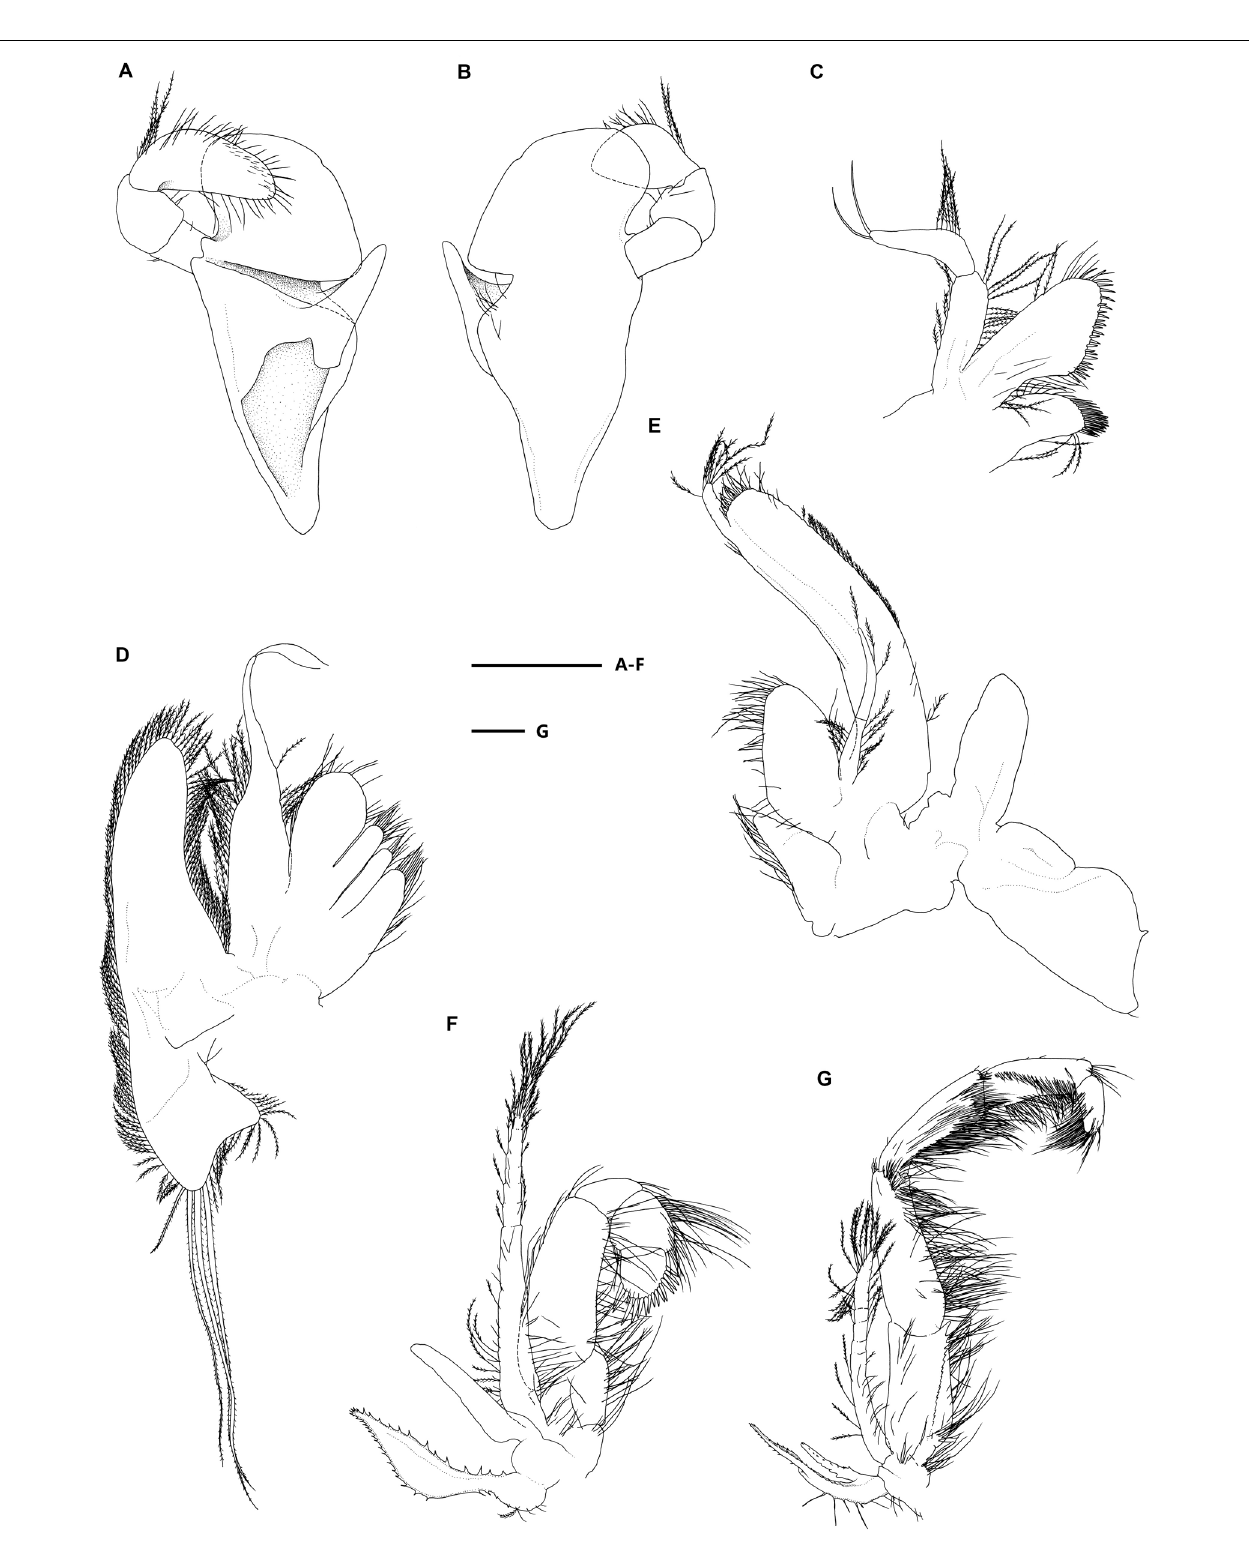
FIGURE 3 | Eiconaxius serratus sp. nov. Holotype, SRSIO 14070301 (ovigerous female, cl 9.0 mm). (A) Mandible, left, inner view; (B) same, outer view; (C) maxillule, left, inner view; (D) maxilla, left, inner view; (E) maxilliped 1, right, inner view; (F) maxilliped 2, left, inner view; (G) maxilliped 3, left, inner view. Scales: 1 mm.